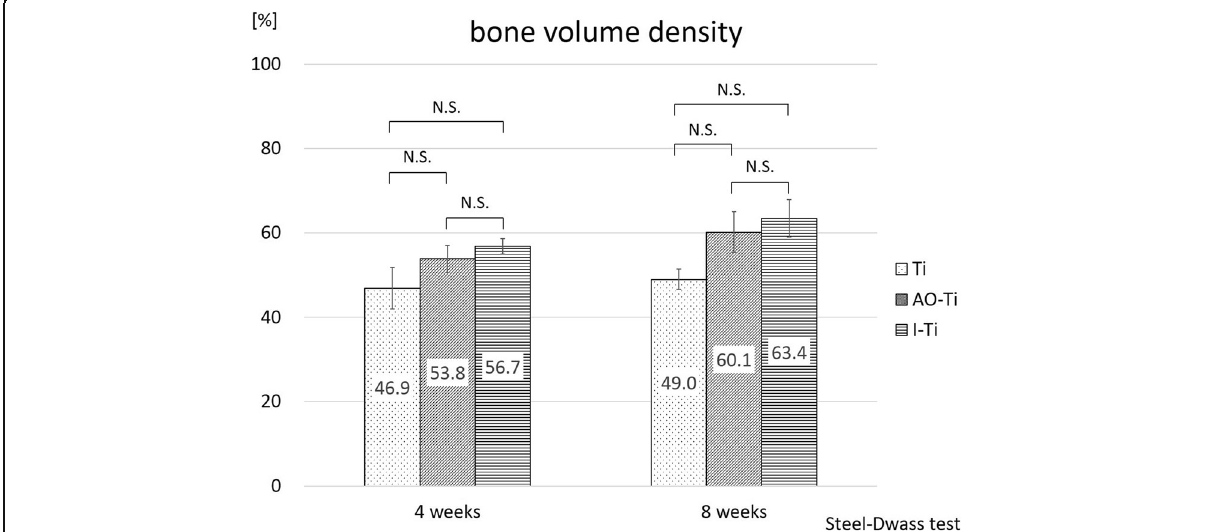
Fig. 8 Results of histological examination (bone volume density). The percentage of bone volume density did not show a significant difference between the Ti, AO-Ti, and I-Ti groups at 4 and 8 weeks after screw